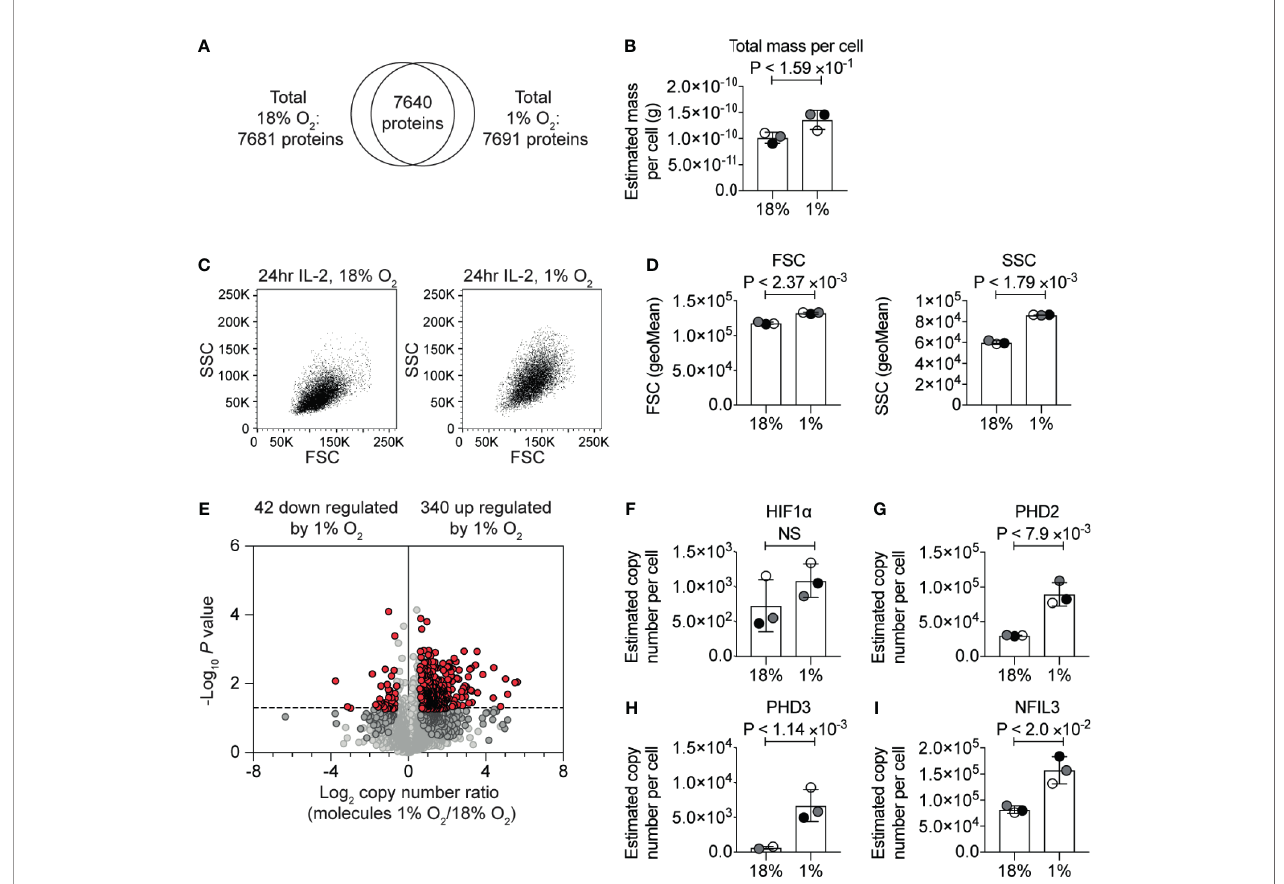
FIGURE 1 | The impact of hypoxia on the CTL proteome. (A) Venn diagram showing the overlap of proteins identi fi ed in the proteomic analysis of IL − 2 maintained CTLs in normoxia (18% O 2 ) and IL − 2 maintained CTLs subjected to hypoxia (1% O 2 ) for 24 hours. (B) Protein content of CTLs in normoxia or subjected to hypoxia for 24 hours calculated using the proteomic data. (C) Representative fl ow cytometry FSC and SSC pro fi les for CTLs in normoxia or after 24 hours in hypoxia. (D) Bar charts showing the average of the geometric mean for the FSC and SSC pro fi les of three biological replicates of CTLs maintained in normoxia or subjected to hypoxia for 24 hours which were acquired at the same time. (E) Volcano plot showing the ratio of the protein copy number in CTLs in hypoxia for 24 hours compared to CTL maintained in normoxia, plotted against P value (two-tailed paired t-test). Proteins signi fi cantly changed (P ≤ 0.05) by greater than 1.5-fold are shown in red. (F – I) Copy numbers estimated from the proteomic data for the indicated proteins. Data show (A, B, D – I) , or are representative of, (C) , three biological replicates. In bar charts, data points from each of the three biological replicates are shown and are colour matched, the bar shows the mean and the error bars show standard deviation. P values were calculated using a two-tailed paired t-test. Non-signi fi cant changes are marked